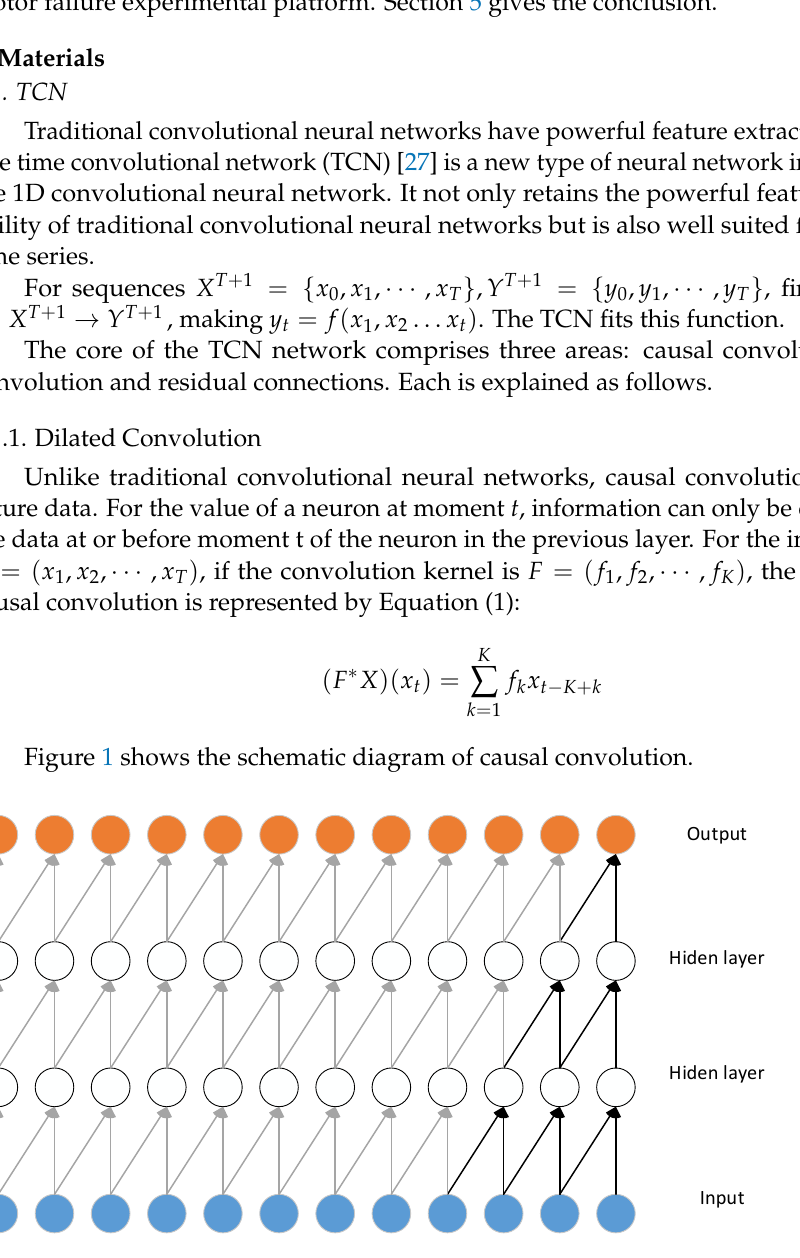
Figure 1. Schematic diagram of causal convolution.